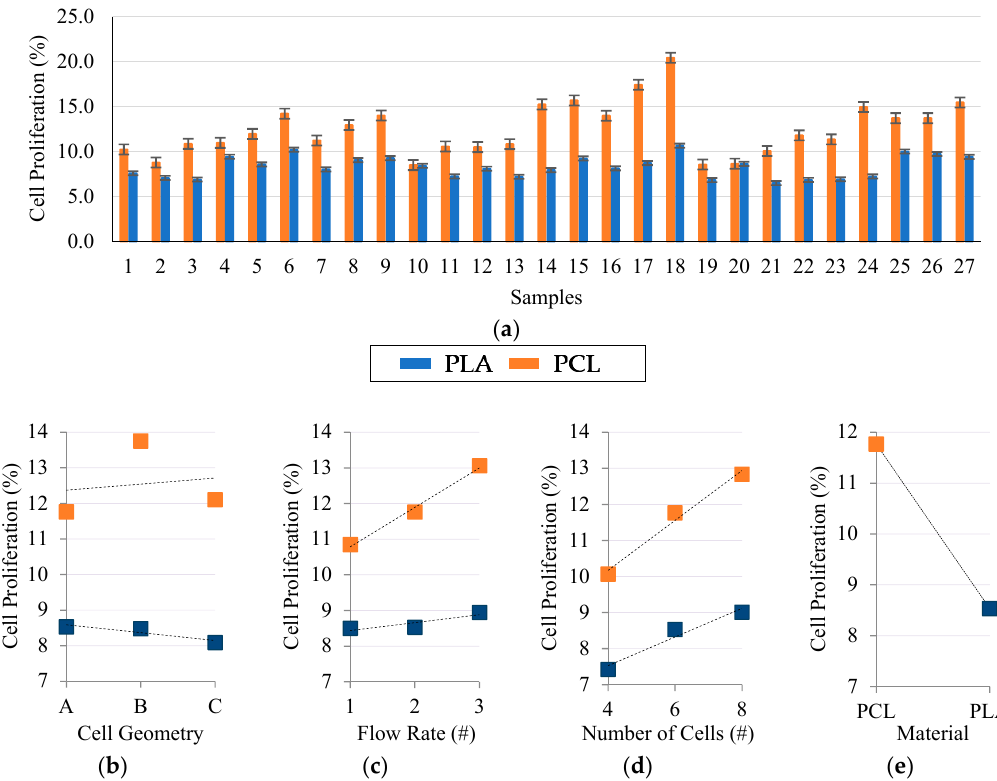
Figure 4. 3T3 Proliferation Results: ( a ) Average cell proliferation on each sample; ( b ) Main effect of cell geometry (6 radial cells, 2nd flow rate); ( c ) Main effect of flow rate (6 radial cells, A Geometry); ( d ) Main effect of number of cells (A Geometry, 2nd flow rate); ( e ) Main effect of plot of materials (6 radial cells, A Geometry, 2nd flow rate).